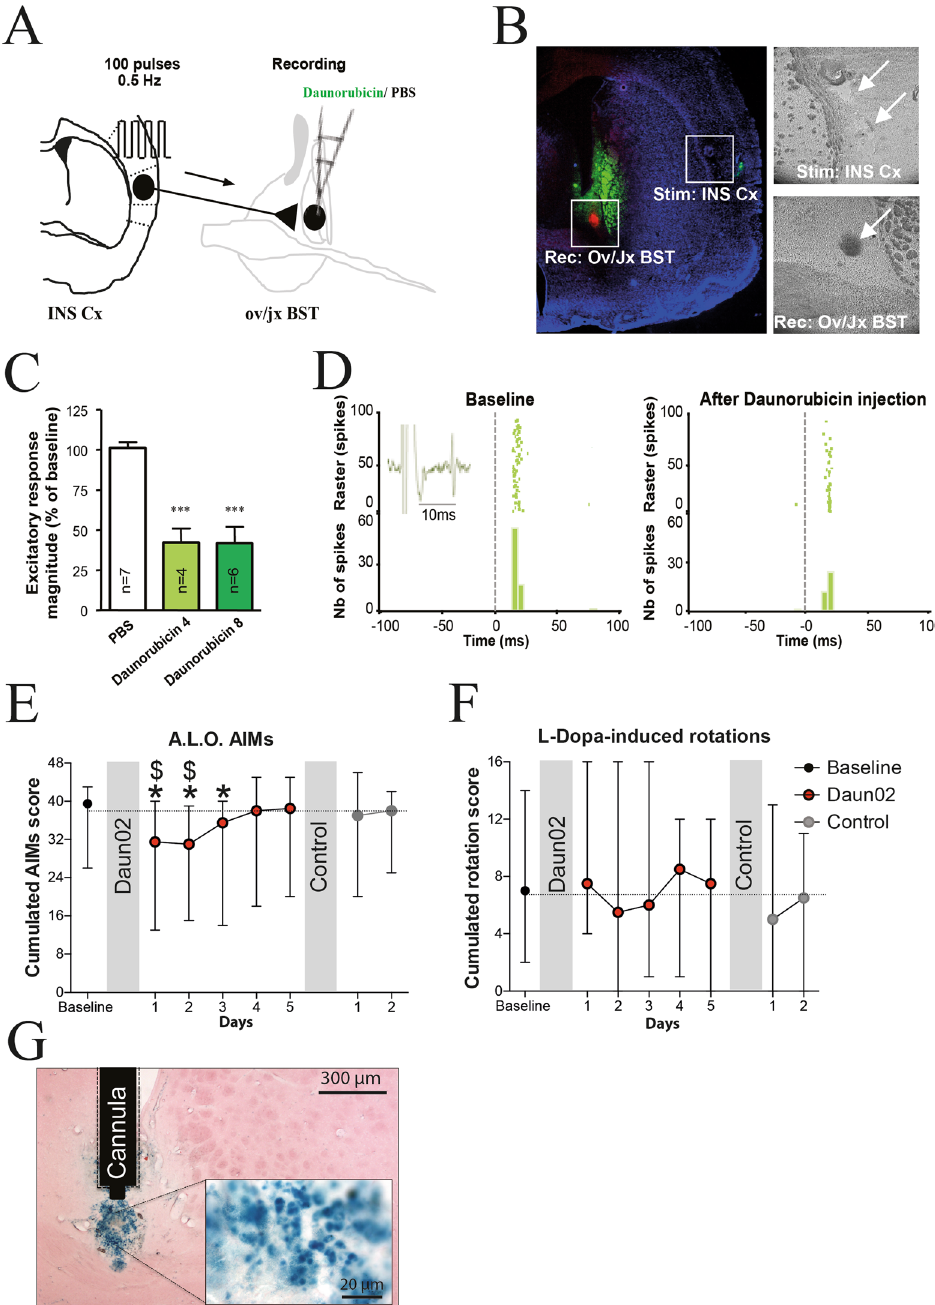
Figure 2. Daun02-induced inactivation of ∆ FosB-expressing dlBST neurons alleviates LID in rats. ( A ) INS Ctx stimulation and ov/jxBST recording protocols. ( B ) Histological controls of stimulation site (stim: INS Ctx), recording site (rec: ov/jx BST; red fluorescent spot), injection site (green fluorescent labeling) (scale bar 1 mm) with 2 representative insets indicating the respective sites with white arrows (scale bar 0.6 mm). ( C ) Quantitative analysis of inhibitions induced by Daunorubicin infusion (Daunorubicin 4: 4 µ g/ µ L; Daunorubicin 8: 8 µ g/ µ L) on excitatory responses evoked by the INS Ctx stimulation. Only neurons responding to Daunorubicin have been included in this analysis (4 out of 7 for Daunorubicin 4 and 6 out of 6 for Daunorubicin 8) ( *** p < 0.001 from PBS). ( D ) Typical PSTHs and associated rasters showing responses of ov/jx BST neurons before and after daunorubicin (4 µ g/ µ L) infusion. Stimulus at t 0 (gray line). Bin width, 5 ms. Representative electrophysiological trace in inset. ( E ) Cumulated axial, limb and orolingual (A.L.O.) AIMs scores in L-Dopa-treated 6-OHDA rats (n = 10) before and after Daun02 and after control solution injection (median ± range; * p < 0.05 from baseline and $ p < 0.05 from control solution). ( F ) Cumulated rotation scores in L-Dopa-treated 6-OHDA rats (n = 10) before and after Daun02 and after control solution injection (median ± range). ( G ) Representative dlBST cytochemical detection of ß-galactosidase expression in the Daun02-injected side of dyskinetic rats (scale bar: 300 µ m) with an inset (scale bar: 20 µ